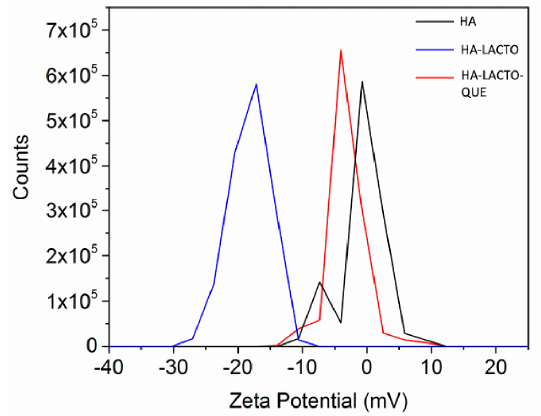
Figure 6. Zeta potential analysis of HA, HA–Lacto, and HA–Lacto–Que.